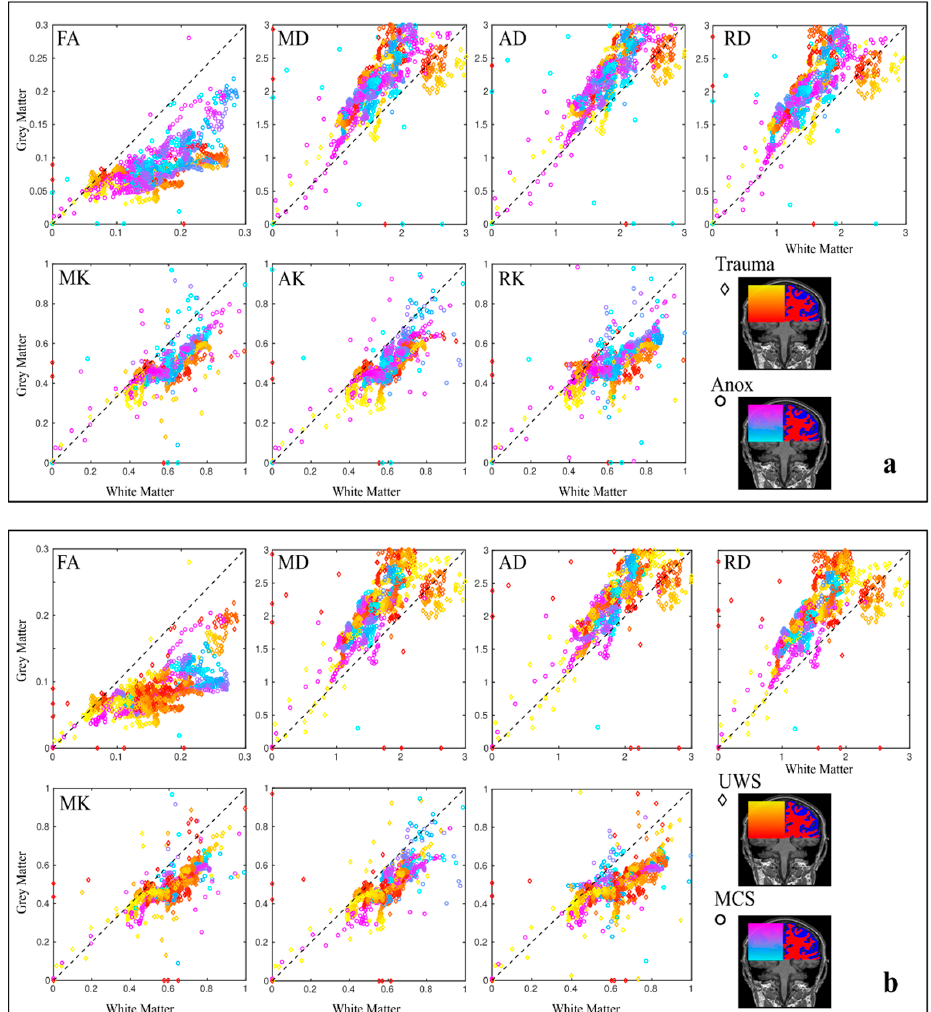
Figure 5. Scatter plots of estimated diffusion metrics for grey/white matter between Trauma/Anox groups ( a ) and unresponsive wakefulness syndrome/ minimally conscious state (UWS/MCS) ( b ). Points on scatter plot are encoded by the colour in respect to the axial slice position and control/patient groups. All diffusion metrics were aligned to T1-weighted individual images. Diffusion units for MD, AD, and RD are in ( μ m 2 /ms). The dashed line presents the linear dependence.